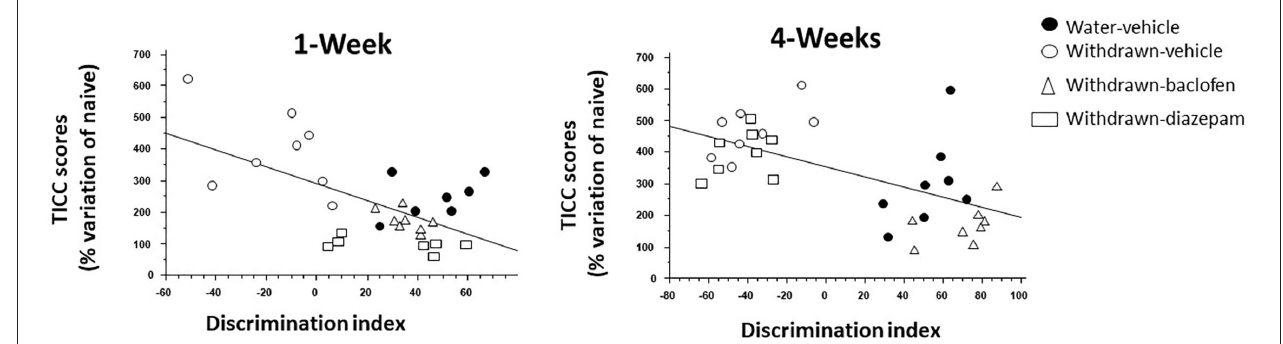
FIGURE 6 | Regression analysis between individual dHPC TICC scores and discrimination indexes in vehicle-Water-controls (hashed squares), withdrawn-vehicle (hashed triangles), diazepam-withdrawn (white circle) and baclofen-withdrawn (black circles) groups. (left): in 1-W groups, a significant negative correlation was observed, the higher being TICC score, the lower being the index discrimination. As can be observed, 1-Week vehicle-withdrawn mice exhibited the lower discrimination index and the higher TICC scores among the 4 groups (right) in 4-Week withdrawn mice, a similar negative correlation was also observed, but in contrast to 1-W withdrawn mice, diazepam-treated withdrawn mice exhibited similar endocrinal and behavioral patterns as vehicle-withdrawn